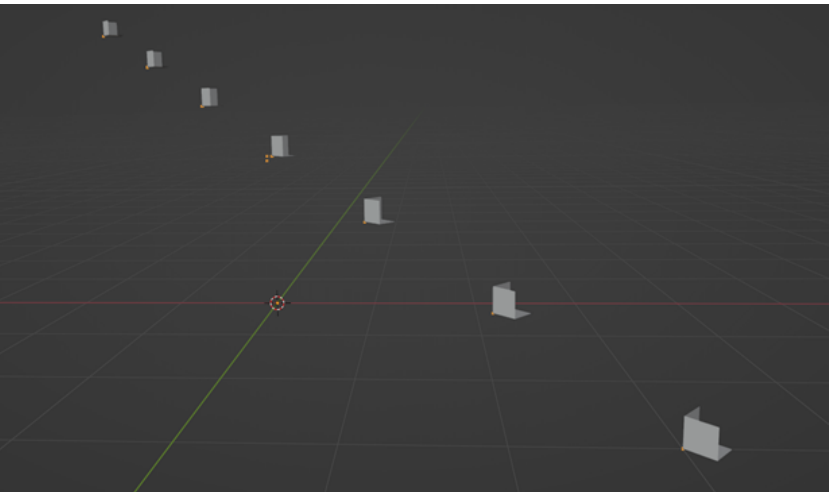
Figure 7. Original CAD model and point cloud reconstruction for seven trihedrals at varying heights.